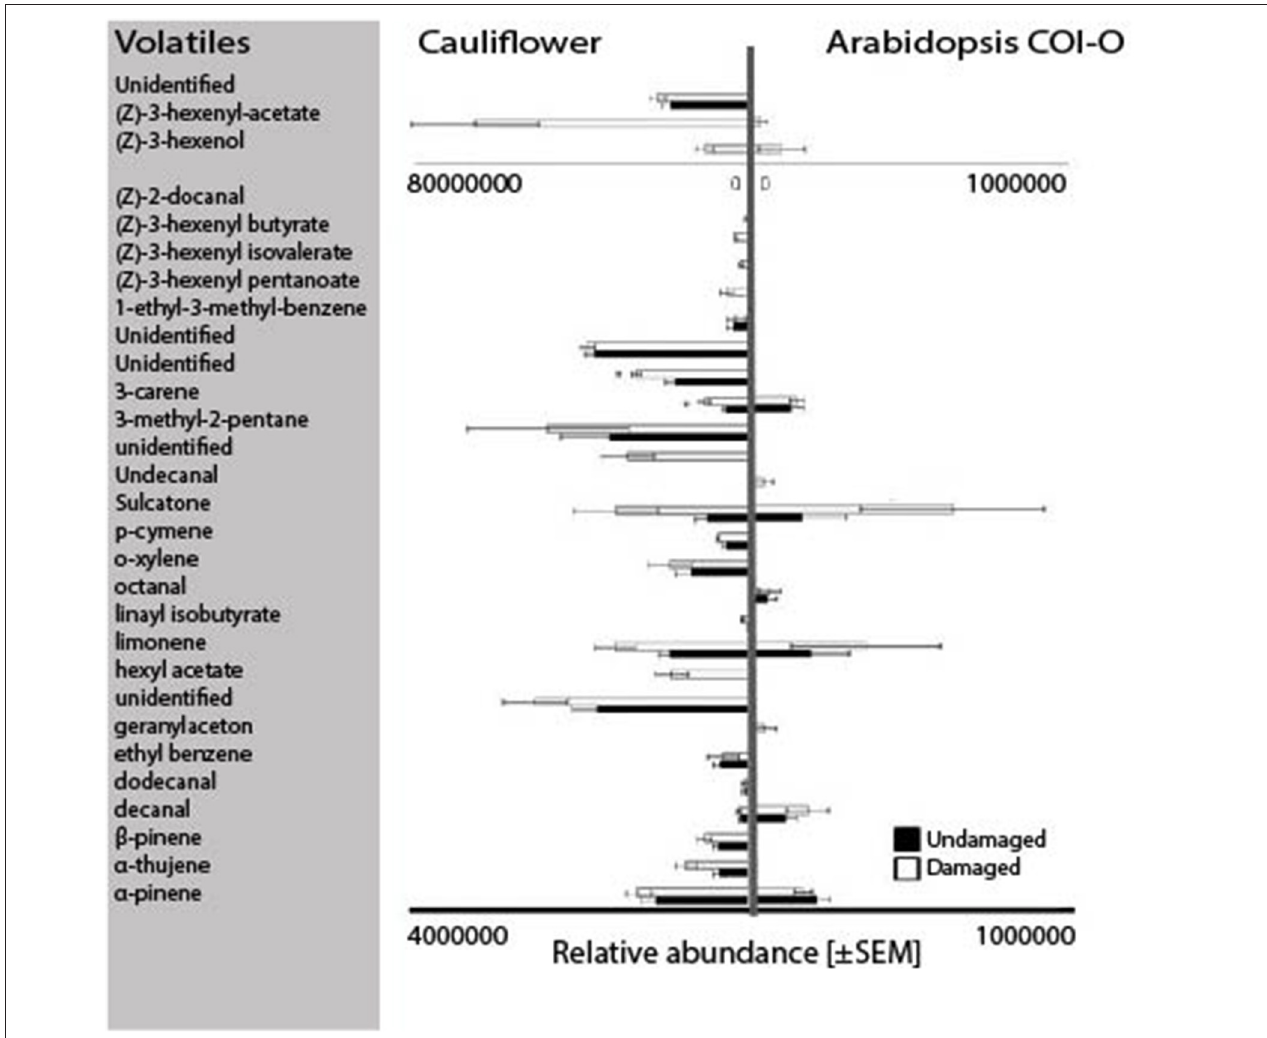
FIGURE 5 | The volatile profiles of cauliflower ( n = 5) and Arabidopsis thaliana Col-0 ( n = 3) for undamaged (black) and damaged (white) plants. The relative abundance of the volatiles is based on solid phase microextraction (SPME) odor collection analyzed using GC-MS. Statistics: Mann-Whitney test with significant differences marked with an asterisk ( P < 0.05). Note: the differing scale bars for A. thaliana Col-0 (0-1 × 106) and for cauliflower (0-4 × 106 or 0–8 × 107), due to large variation in emitted